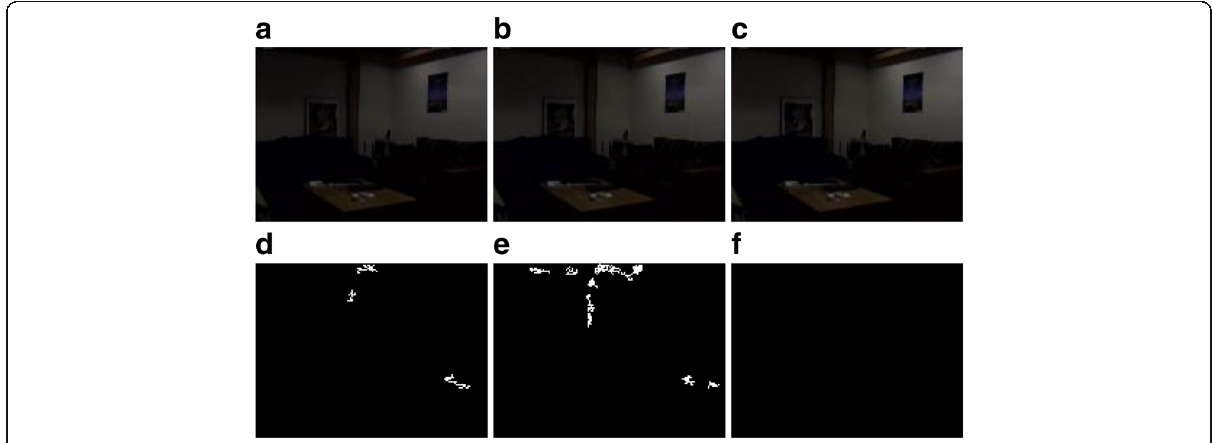
Fig. 9 Long-term background model update. a – c Original image frames 370, 410, and 450. d – f Segmented